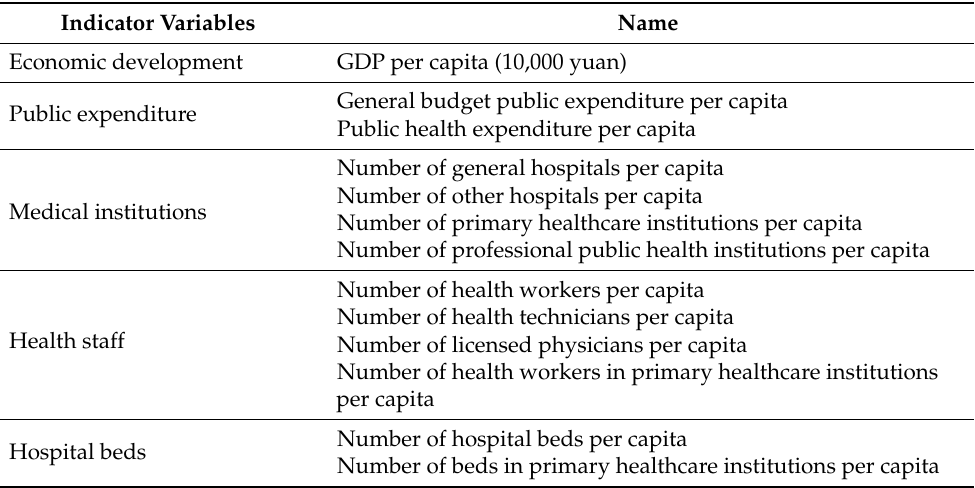
Table 3. Economic development and medical resources.